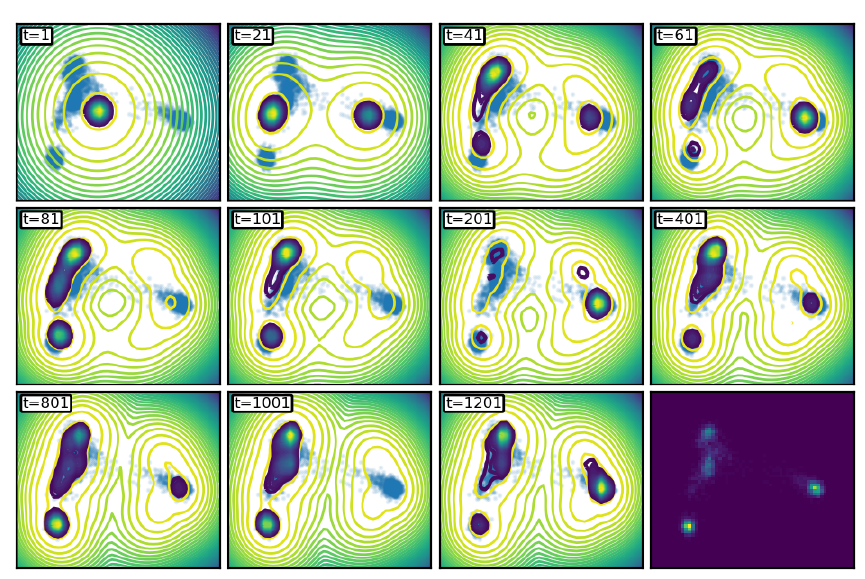
Figure 11: Evolution of the potential along the second and third principal directions during the learning of the TMC-RBM. We clearly observe how the second direction is learned by the RBM, followed by the third. After one thousand parameter updates, the reconstructed probability distribution covers the